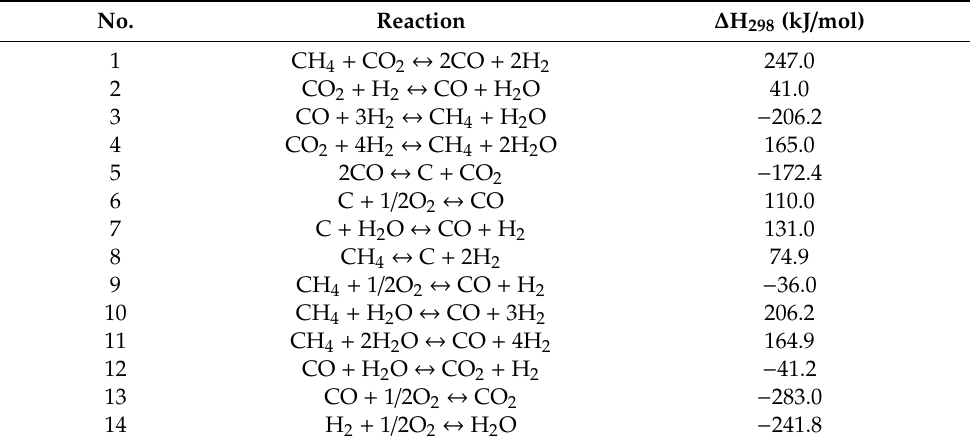
Table 1. Reactions occurring during dry and wet reforming of